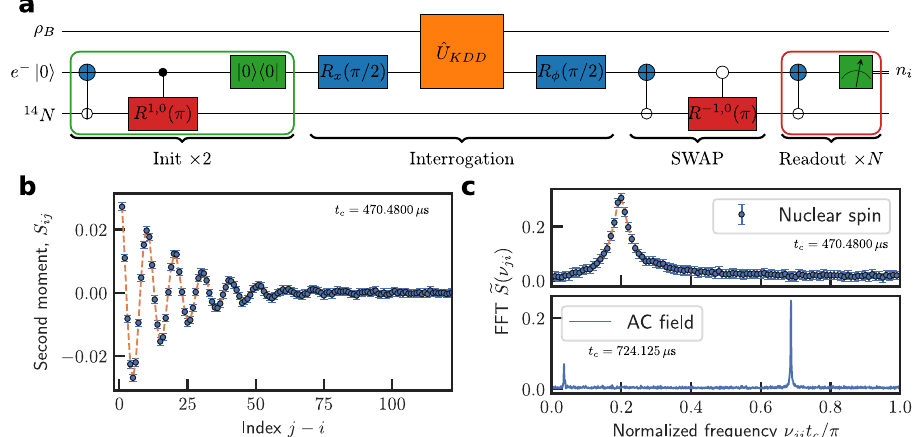
Fig. 2 | Statistics of sequential measurements on a sensor spin. a Protocol of state is repeatedly readout throughthe electron spinviaaCNOT gate and photon counts. b Second moment S ij of sequential measurement ofa sensor spin coupled sequential measurement. The sensor spin and the ancilla are initialized by an to a 13 C nuclearspin. c Fourier transform of the second moment for a nuclear spin optical pump (green block being a pulse of 532nm laser) and SWAP gates (repe- (upper) and a random-phased AC fi eld (lower). The extra small peak at lower pulse (blue ated twice for higher fi delity). Then the sensor spin is rotated by a π 2 frequency in lower graph of c is not from the AC fi eld, as checked by the depen- block), controlled by a dynamical decoupling sequence, and rotated again by a π 2 pulse (withareadoutangle θ fromthe fi rst π pulseso that ^ σ θ is measured).The NV dence of its amplitude on the measurement direction e θ (see Fig. S5 in Supple- 2 electron spin state is then stored in the 14 N spin by a SWAP gate and the 14 N spin mentary Note